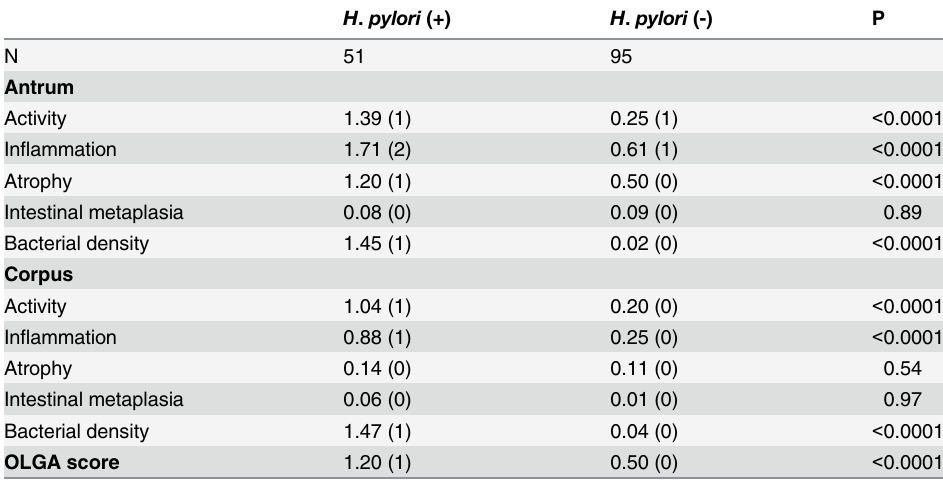
Table 2. Histological scores according to H. pylori infection status by